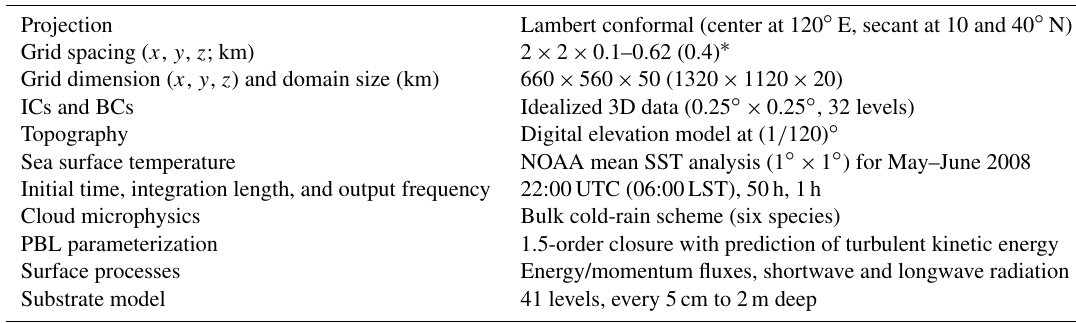
Table 2. The setup of CReSS model domain, ICs and BCs, and physical schemes in this study.